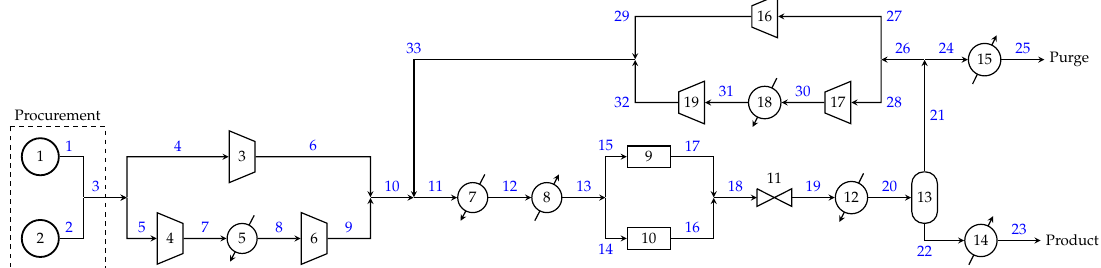
Figure 3. Methanol process flowsheet superstructure, adapted from [22], showing stream numbers in